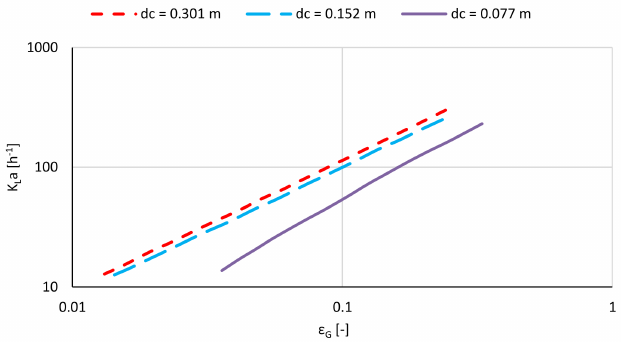
Figure 31. Influence of the bubble column diameter on k L a —data from Akita and Yoshida [47]—water and O 2 , 30 ◦